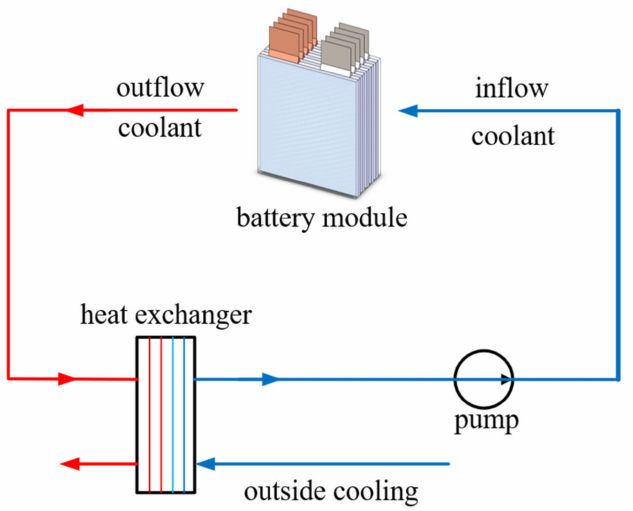
Figure 5. Structure of the BTMS with immersion